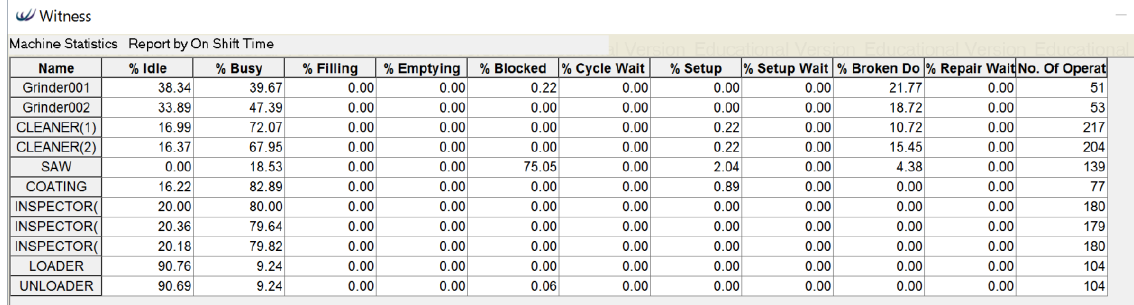
Figure 14. Re-engineered and optimized process.